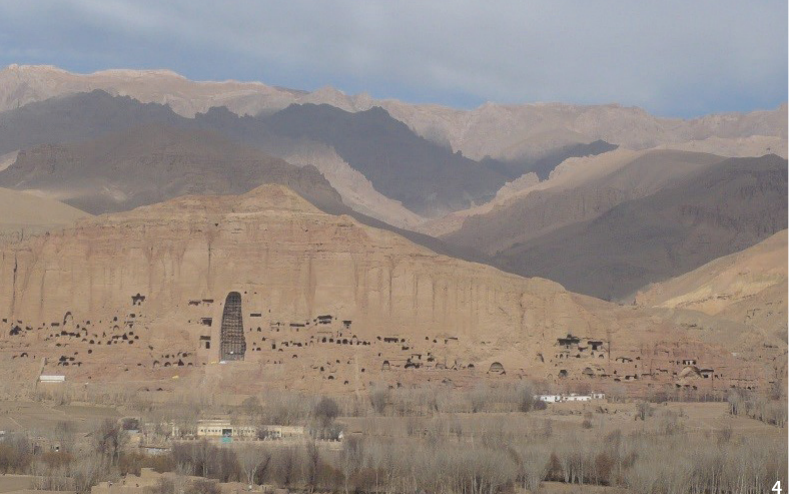
Figure 4 The Cultural Landscape and Archaeo- logical Remains of the Bamiyan Valley, Afghani- stan (Source: Roland Chih-Hung Lin).